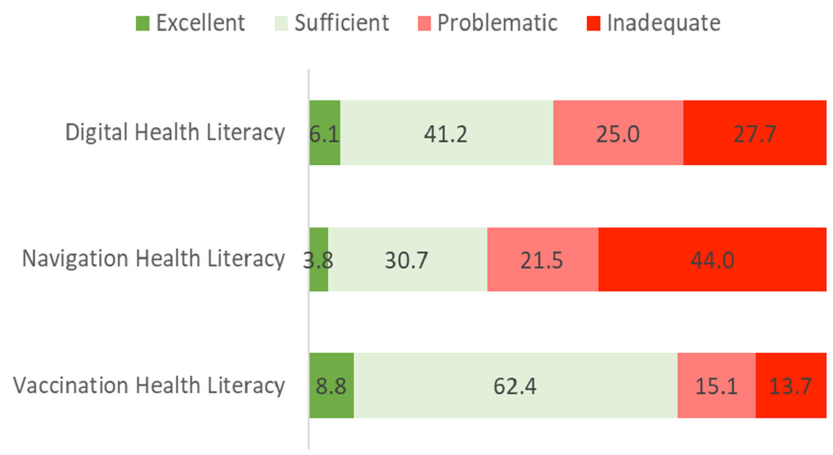
Figure 4. Distribution of the digital health literacy, navigational health literacy, and vaccination health literacy levels of the Portuguese HLS 19 sample.